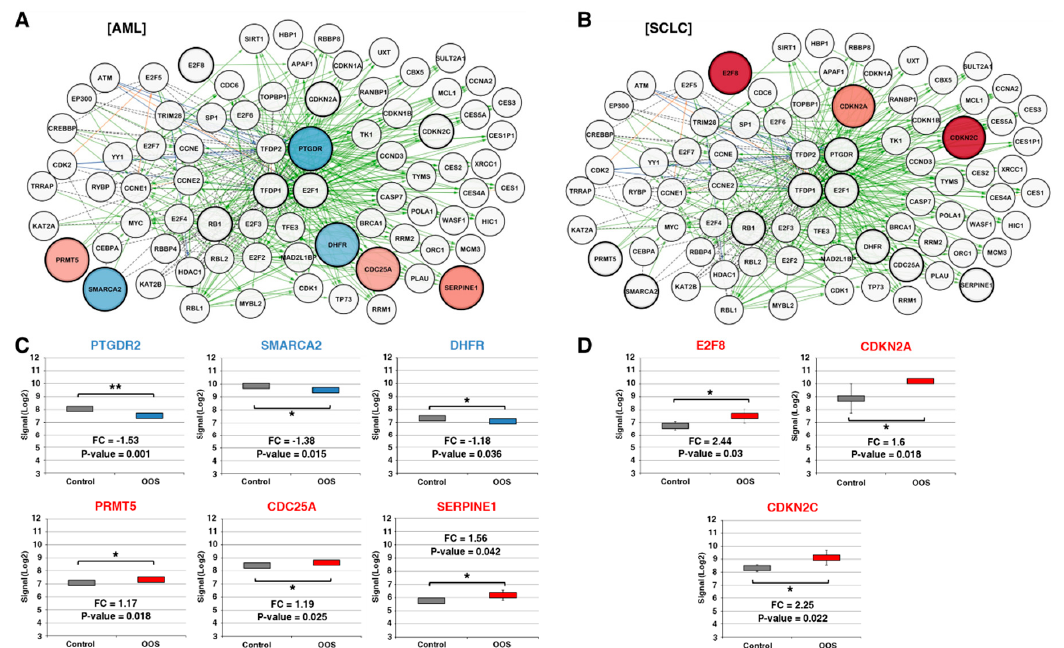
Figure 3. Components of the E2F transcriptional network are deregulated after OOS treatment. ( A ). Cytoscape software representation of the E2F transcriptional network, composed of a total of 80 interactors in the AML model. Overexpressed genes are displayed in shades of pink-red, and downregulated genes in shades of blue; the color intensity is proportional to the fold-change values. Black dotted labels define “in complex with” interactions, green solid labels define “controls expression of” interactions, blue labels define “controls state change of” interactions, and orange labels “controls phosphorylation of” interactions. ( B ) Similarly, E2F transcription network is shown in SCLC. ( C ) Statistically significant deregulated E2F pathway genes in AML or in SCLC ( D ). Names in red indicate overexpression after OOS treatment, while those in blue are indicative of OOS downregulation. * indicate statistically significant di ff